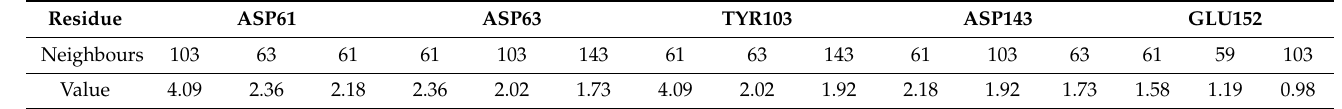
Table A3. shows the first three neighbors with the greatest influence on the pKa change of each residue and the quantized value of influence.